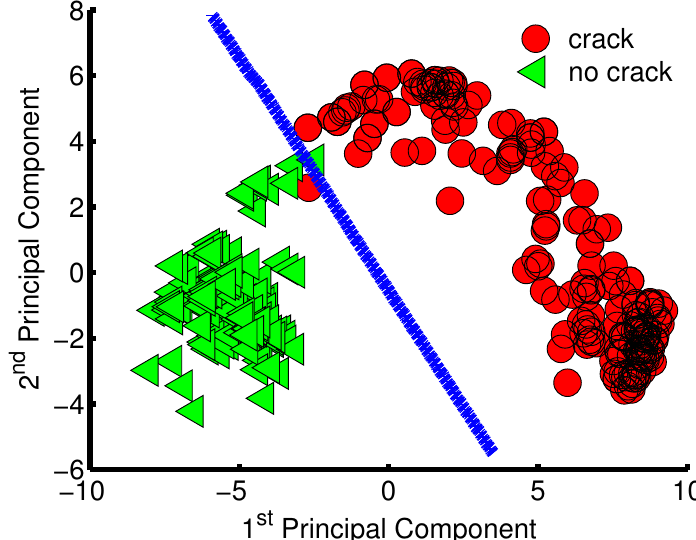
Figure 10. The combined model decision boundary (2-d Principal Component Analysis (PCA)